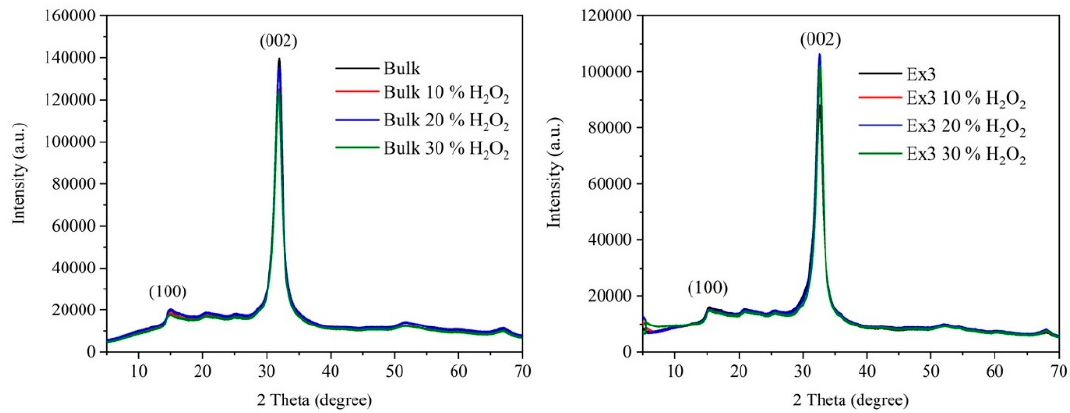
Figure 3. X-ray diffraction (XRD) patterns of bulk ( left ) and exfoliated nanomaterials ( right ). Figure 3. X-ray di ff raction (XRD) patterns of bulk ( left ) and exfoliated nanomaterials ( right Table 3. XRD characteristics of GCN nanomaterials.